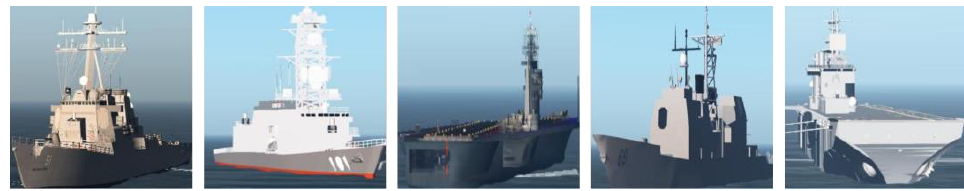
Figure 4. Simulation ship images.